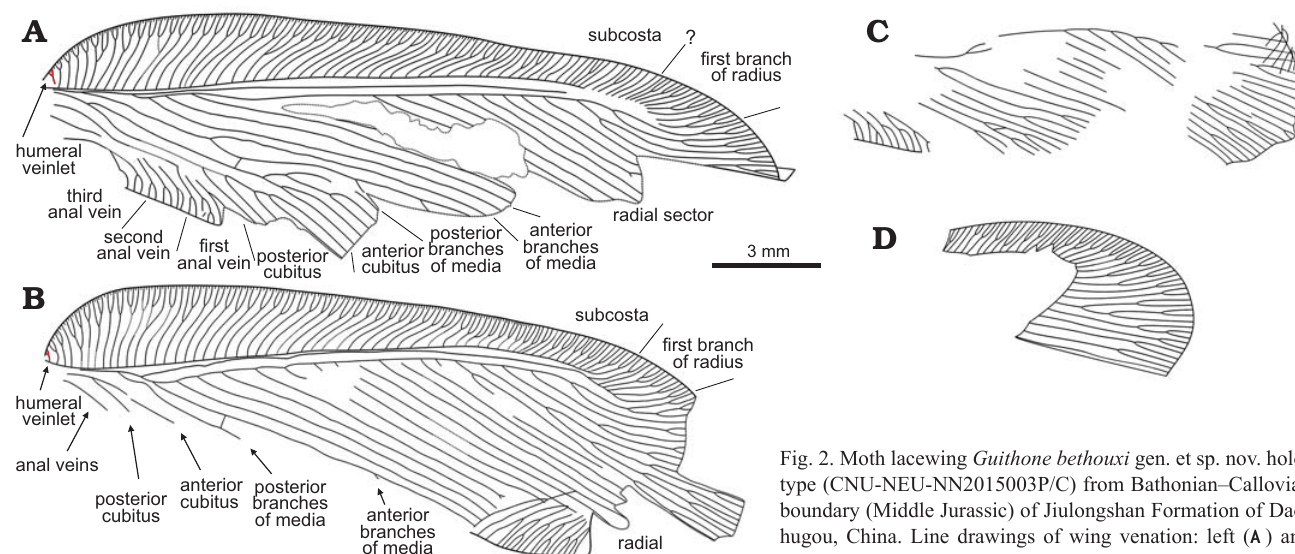
Fig. 2. Moth lacewing Guithone bethouxi gen. et sp. nov. holo- type (CNU-NEU-NN2015003P/C) from Bathonian–Callovian boundary (Middle Jurassic) of Jiulongshan Formation of Dao- hugou, China. Line drawings of wing venation: left ( A ) and right ( B ) forewings, left ( C ) and right ( D )